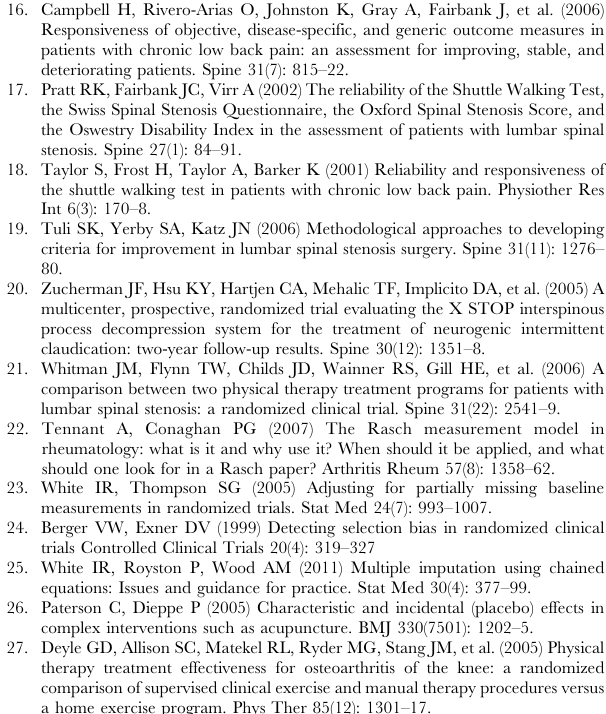
Table S1 Baseline characteristics of patients for whom P(E) ? 0.5. Table S2 Changes in primary, secondary and explor- atory outcomes at eight weeks and 12